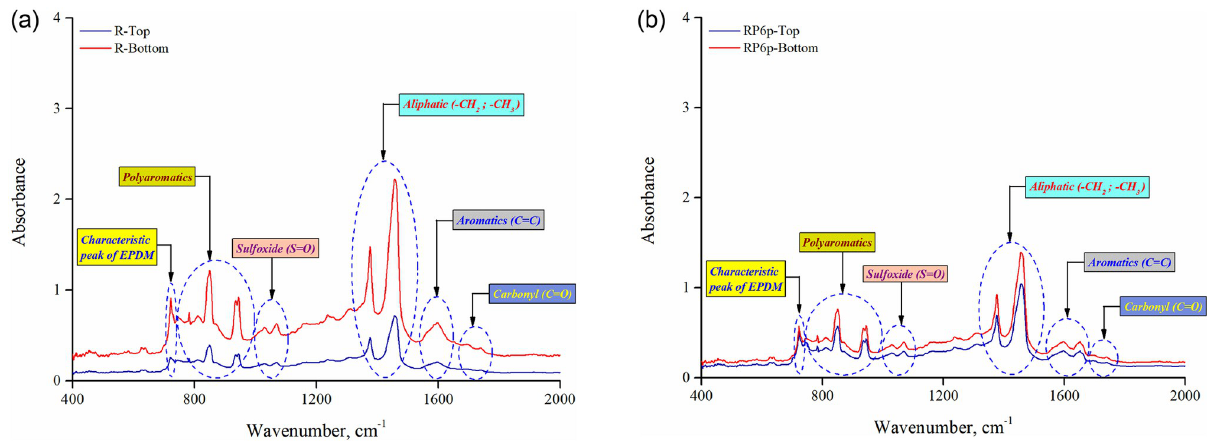
Fig 9. FTIR spectra of top and bottom parts of (a) binder R and (b) binder RP6p.